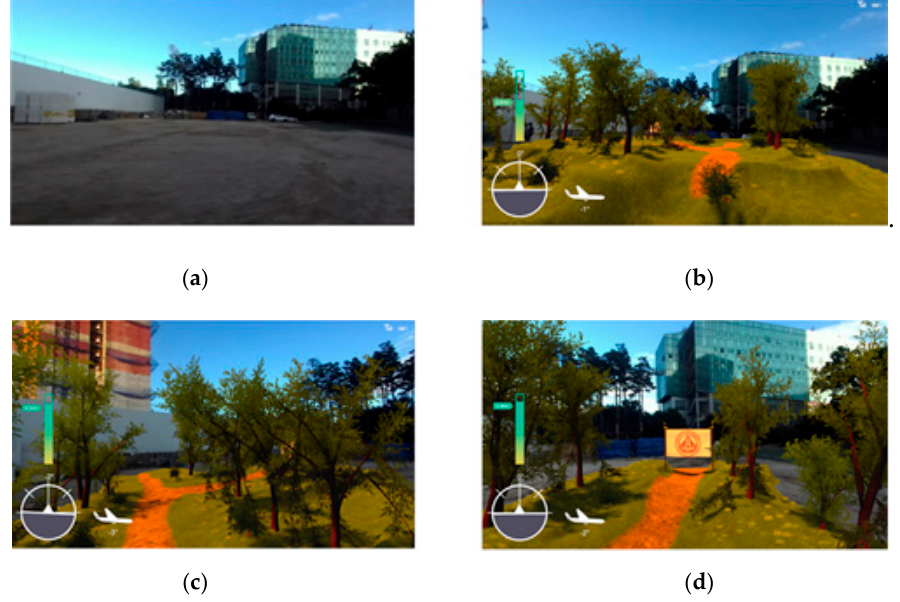
Figure 3. ( a – d ) First-person-view of a drone in mixed reality combining a real world with a virtual forest.